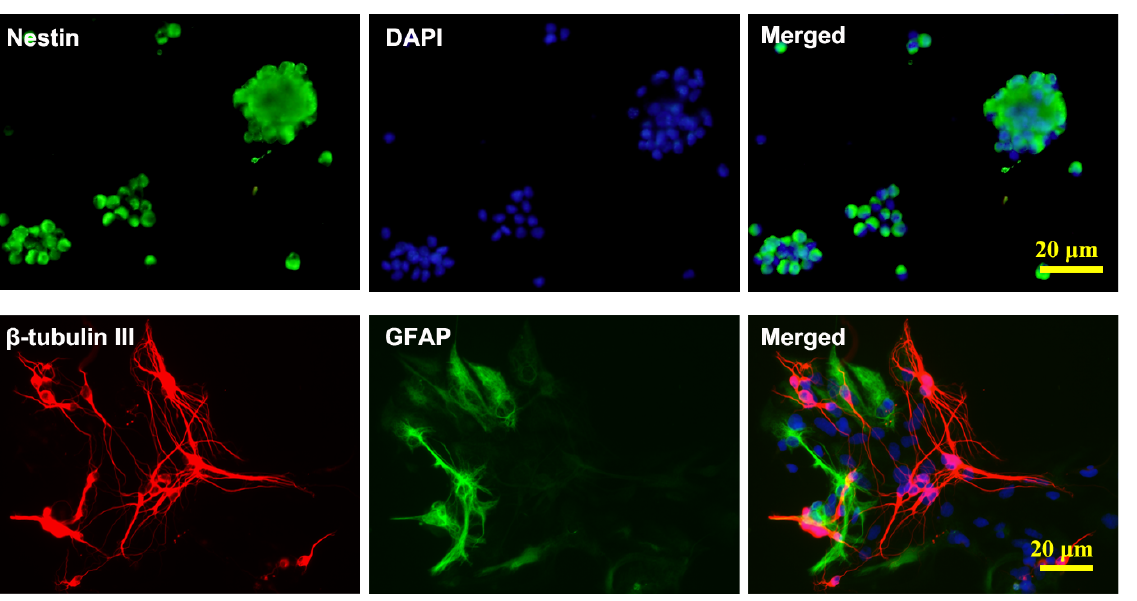
Figure 1. Culture and identification of NSCs. ( A ) Cells in spheres were nestin positive. ( B ) The β - tubulin III positive cells and GFAP positive cells were observed after 7 days of culture in the differ- entiation medium. Scale bars = 20 μ m.